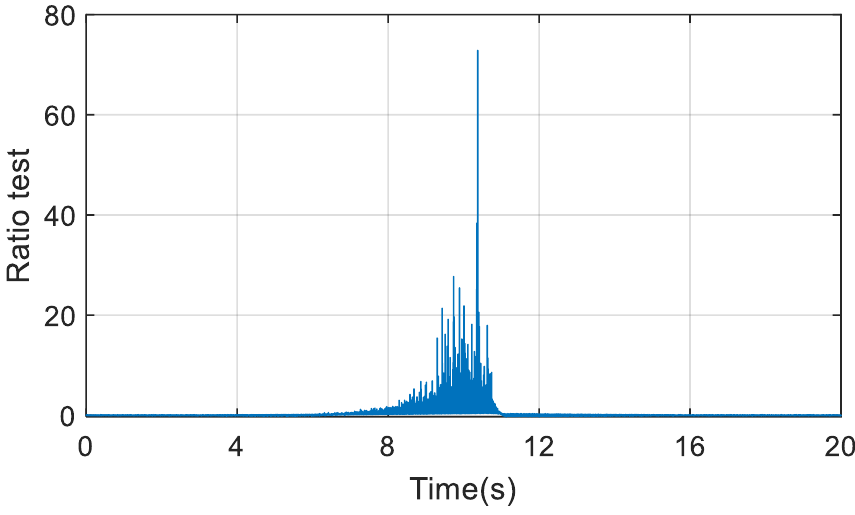
Figure 22. Ratio Test metric behavior under traction Strategy 1.